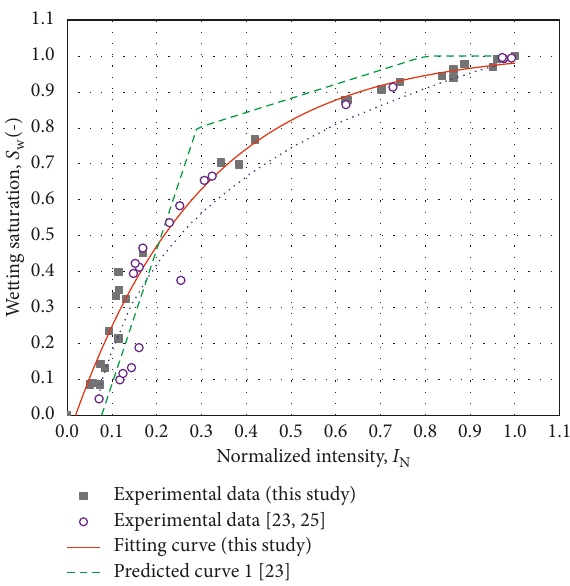
Figure 5: Relationship between saturation ( S w )-normalized pixel intensity ( I N ), compared with measured saturation-intensity pairs in the study of Peters et al. [23] and Sills et al. [25].